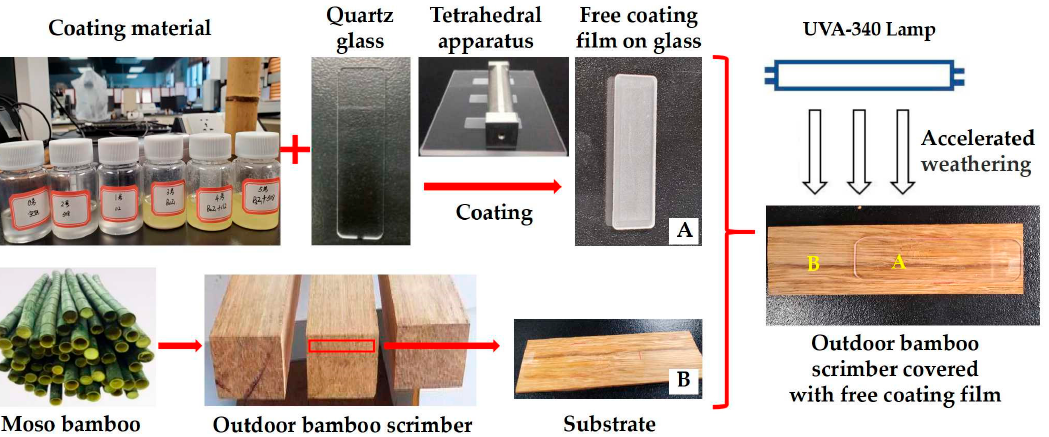
Figure 2. Preparation of weatherability OBSs coated with free films.